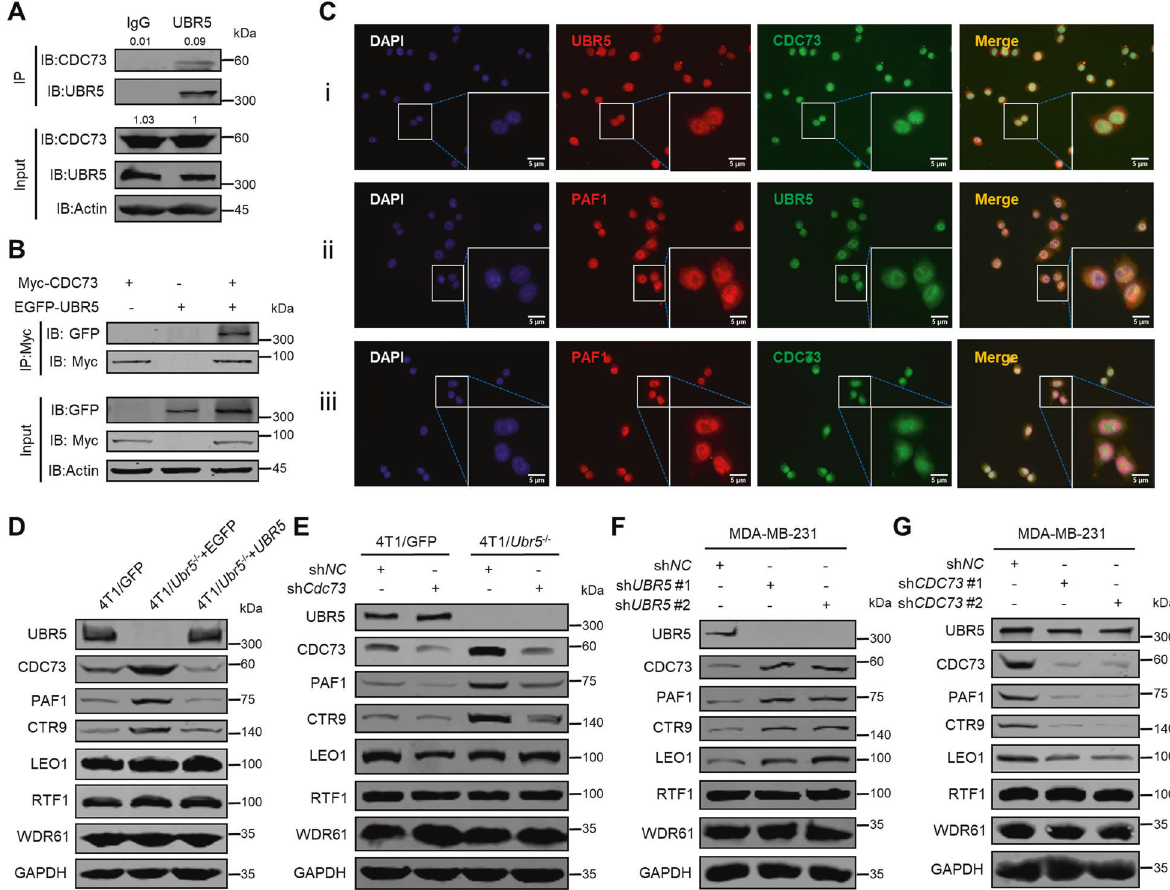
Fig. 5 Interaction of UBR5 with CDC73/PAF1C. A Physical interaction of endogenous UBR5 with endogenous CDC73 was detected by co-IP with anti-UBR5 antibody in 4T1 cells which were treated with MG132 (10 μ M) for 8 h before being collected for co-IP. B Physical interaction of exogenous UBR5 with exogenous CDC73 was monitored by co-IP with anti-Myc antibody in HEK293T cells transfected with empty vector, Myc-CDC73 or/and EGFP-UBR5 expressing plasmids for 40 h and then treated with MG132 (10 μ M) for 8 h before being collected for co-IP. C The co-localization of endogenous UBR5 and CDC73 (i), UBR5 and PAF1 (ii), and CDC73 and PAF1 (iii) in 4T1 cells was monitored by immuno fl uorescence with a fl uorescent microscope. The protein levels of UBR5 and the subunits of PAF1C including CDC73, PAF1, CTR9, LEO1, RTF1, and WDR61 were detected by western blotting in 4T1/GFP and 4T1/ Ubr5 − / − cells reconstituted with EGFP or UBR5 ( D ), 4T1/GFP sh NC , 4T1/GFP sh Cdc73 , 4T1/ Ubr5 − / − sh NC , and 4T1/ Ubr5 − / − sh Cdc73 cells ( E ), sh NC and UBR5 knockdown MDA-MB-231 cells ( F ), and sh NC and CDC73 knockdown MDA-MB-231 cells ( G